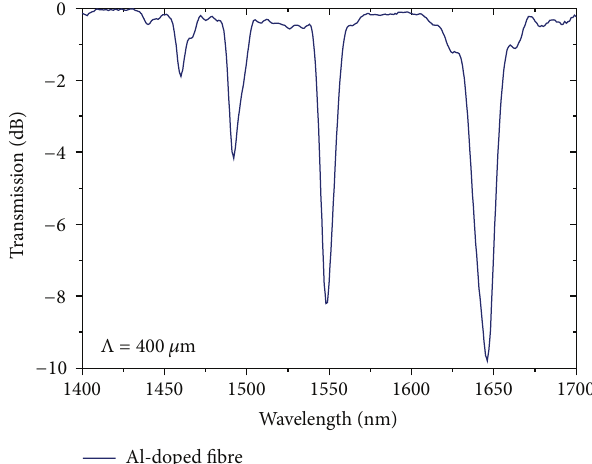
Figure 1: Typical spectrum of a 400 𝜇 m-LPFG inscribed in an Al- doped fibre.